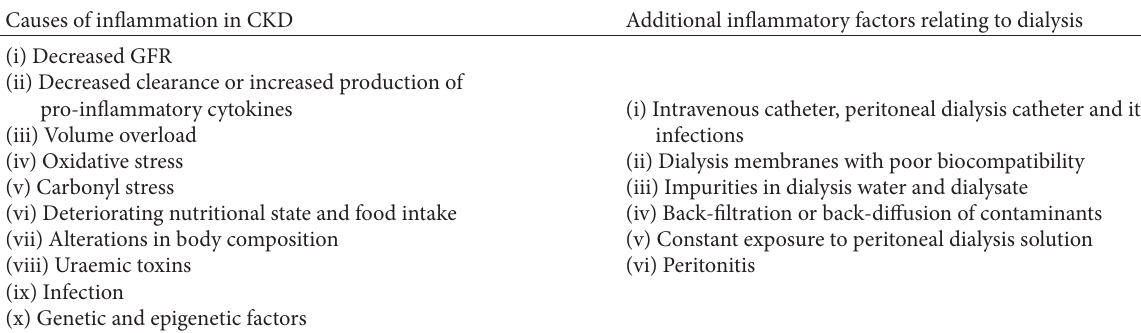
Table 2: Summary of the potential causes of chronic inflammation in chronic kidney disease (adapted from Cheung et al. [26]). Causes of inflammation in CKD Additional inflammatory factors relating to